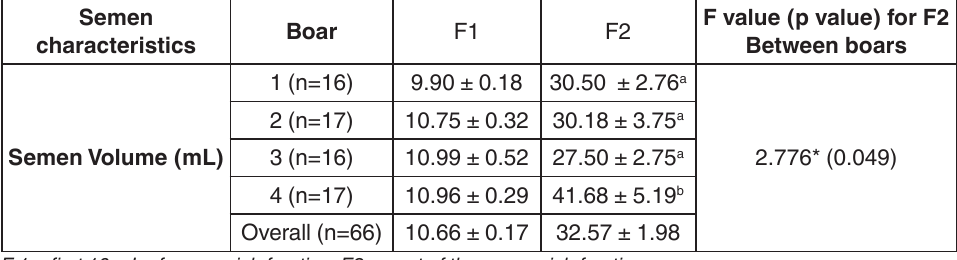
Table 1. Semen volume (Mean ± SE) in different fractions of Large white Yorkshire boar fresh semen ejaculate